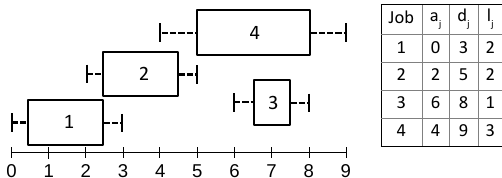
Figure 1. Sample jobs with arrival times, deadlines, lengths, and job configuration lists: L 1 = { 1 } , L = { 1,2 } , L = { 2,3 } , L = { 2,3,4 } 2 3 4